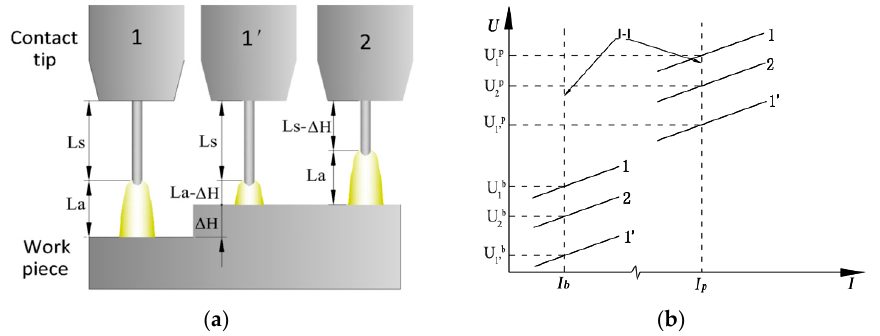
Figure 2 . Voltage signal when the CTWD decreases: ( a ) arc length and stickout variation; ( b ) voltage changing process. The superscript p represents the pulse voltage and b represents the base voltage.